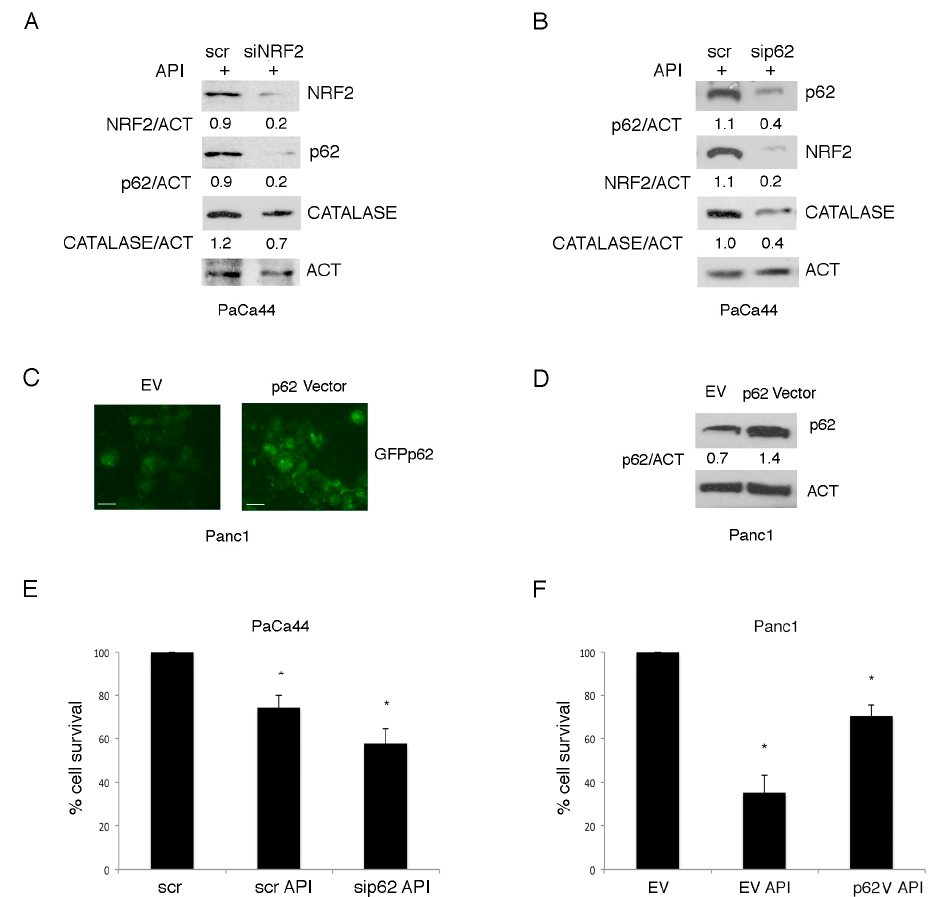
Figure 5. Positive feed-back loop between p62 and NRF2 mediated by mutp53. NRF2, p62, and catalase expression was evaluated by western blot analysis in ( A ) siNRF2- or scramble-silenced PaCa44 cells treated with Apigenin and ( B ) sip62- or scramble-silenced PaCa44 cells treated with Apigenin. Actin was used as loading control. A representative experiment out of three is shown and the densitometric analysis of the ratio of NRF2 / actin, p62 / actin and catalase / actin is reported; ( C ) Photographs of p62 positive Panc1 cells, transfected with empty vector plasmid (EV), and GFP-p62 vector plasmid observed by fluorescence microscope; Scale bar: 10 mm. ( D ) p62 expression of transfected with empty vector plasmid (EV) and GFP-p62 vector plasmid Panc1 cells evaluated in western blot analysis. Actin was used as loading control and the densitometric analysis of the ratio of p62 / actin is reported. ( E ) Viability of p62- or scramble-silenced PaCa44 cells treated with Apigenin was evaluated by trypan blue exclusion assay. Mean plus SD of three independent experiments is reported. * p -value < 0.05; ( F ) Viability of p62- or empty-vector transfected Panc1 cells treated with Apigenin was evaluated by trypan blue exclusion assay. Mean plus SD of three independent experiments is reported. * p -value < 0.05. Control (CT); Apigenin (API); nuclear factor erythroid 2 like 2 (NRF2); actin (ACT); control siRNA scrambled sequence (scr); NRF2 siRNA (siNRF2); p62 siRNA (sip62); empty vector (EV); p62 vector (p62V).